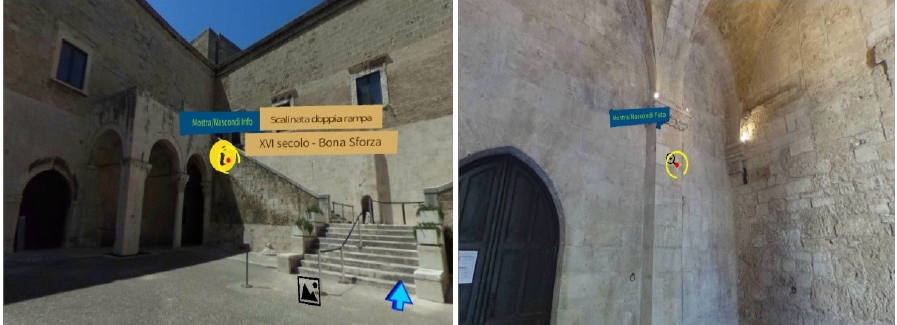
Figure 1. Different types of interaction